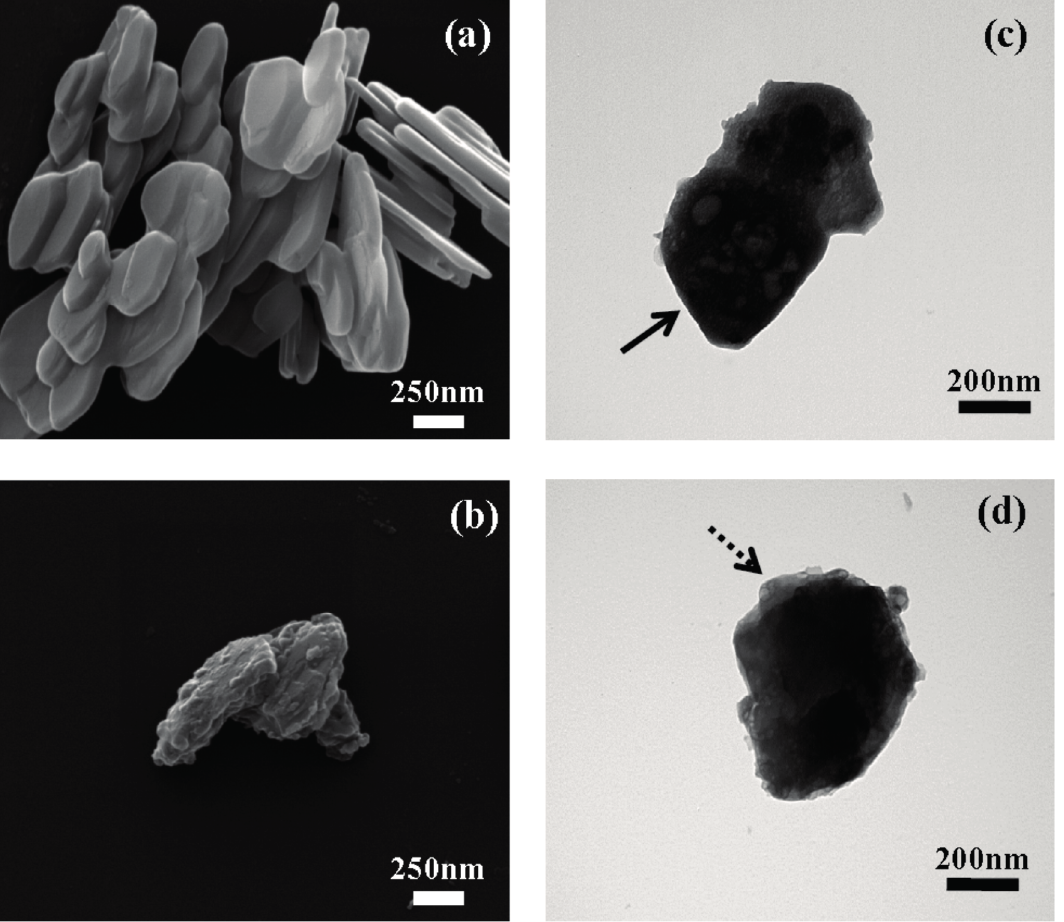
Figure 3. SEM images of ( a ) pristine CaAl-LDH and ( b ) E-coated CaAl-LDH. TEM images of ( c ) pristine CaAl-LDH and ( d ) E-coated CaAl-LDH. The arrow in ( c ) and the dashed arrow in ( d ) stand for the sharp edge of pristine LDH and blunt part of E-coated CaAl-LDH,